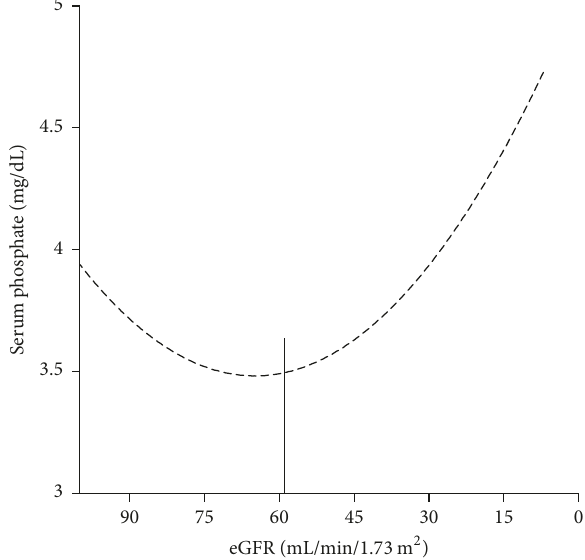
Figure2: Serumphosphateaccordingtokidneyfunction .Verticalline represents the change in slope. Modified from Chartsrisak et al.